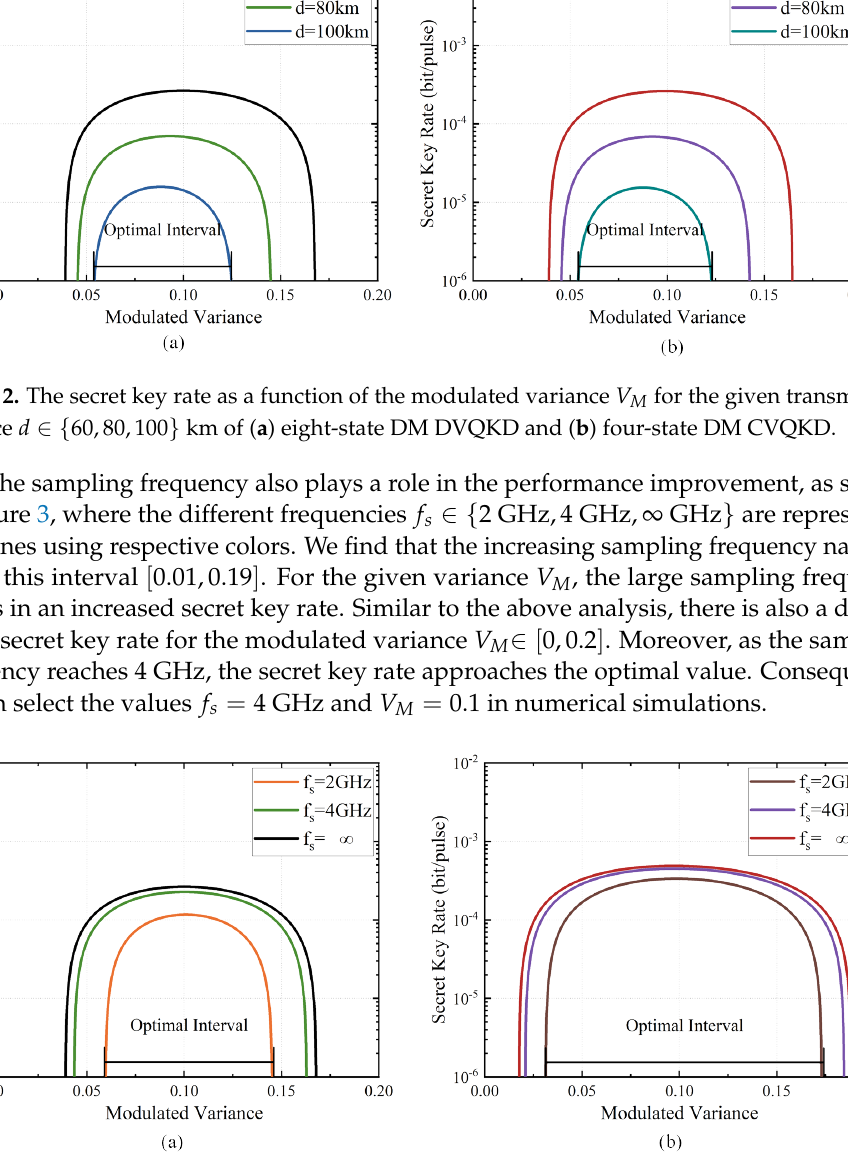
Figure 3. The secret key rate as a function of the modulated variance with sampling frequency f s ∈ { 2,4, ∞ } GHz of ( a ) eight-state DM DVQKD and ( b ) four-state DM